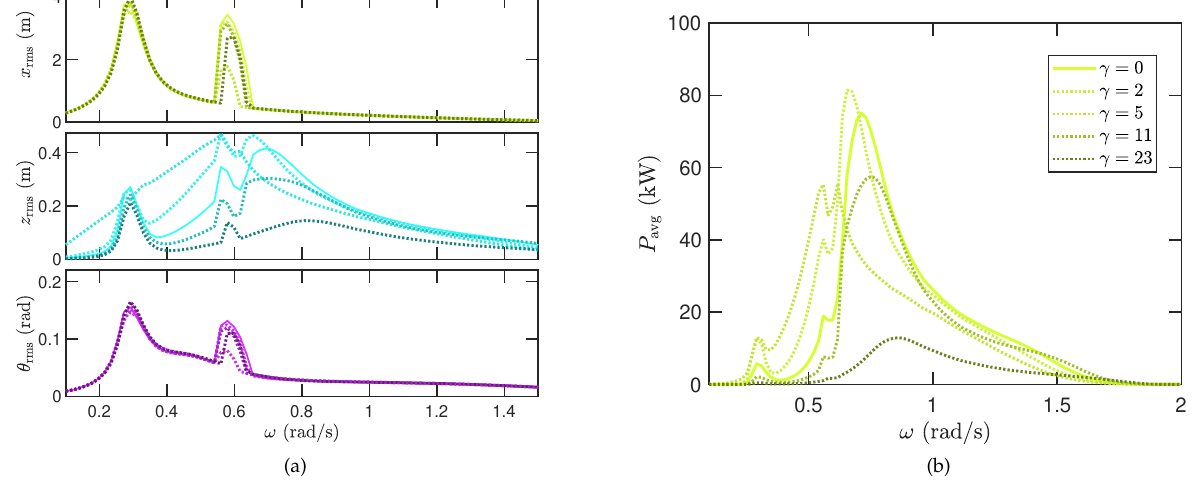
Fig. 13. The RMS of the motion (13a) and the time-averaged power (13b) for the 3-DOF scenario and varying γ (indicated by varying shade) where the PTO is tuned for ω = 0 . 77 rad / s .